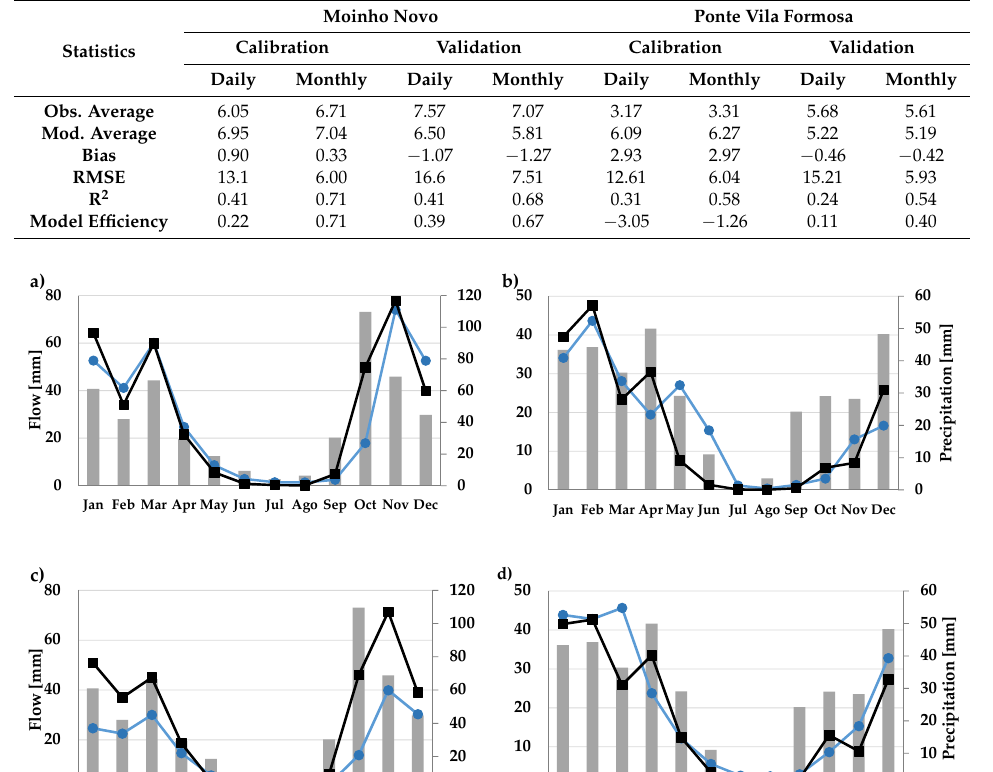
Table 4. The daily and monthly flow statistics at Moinho Novo and Ponte Vila Formosa.